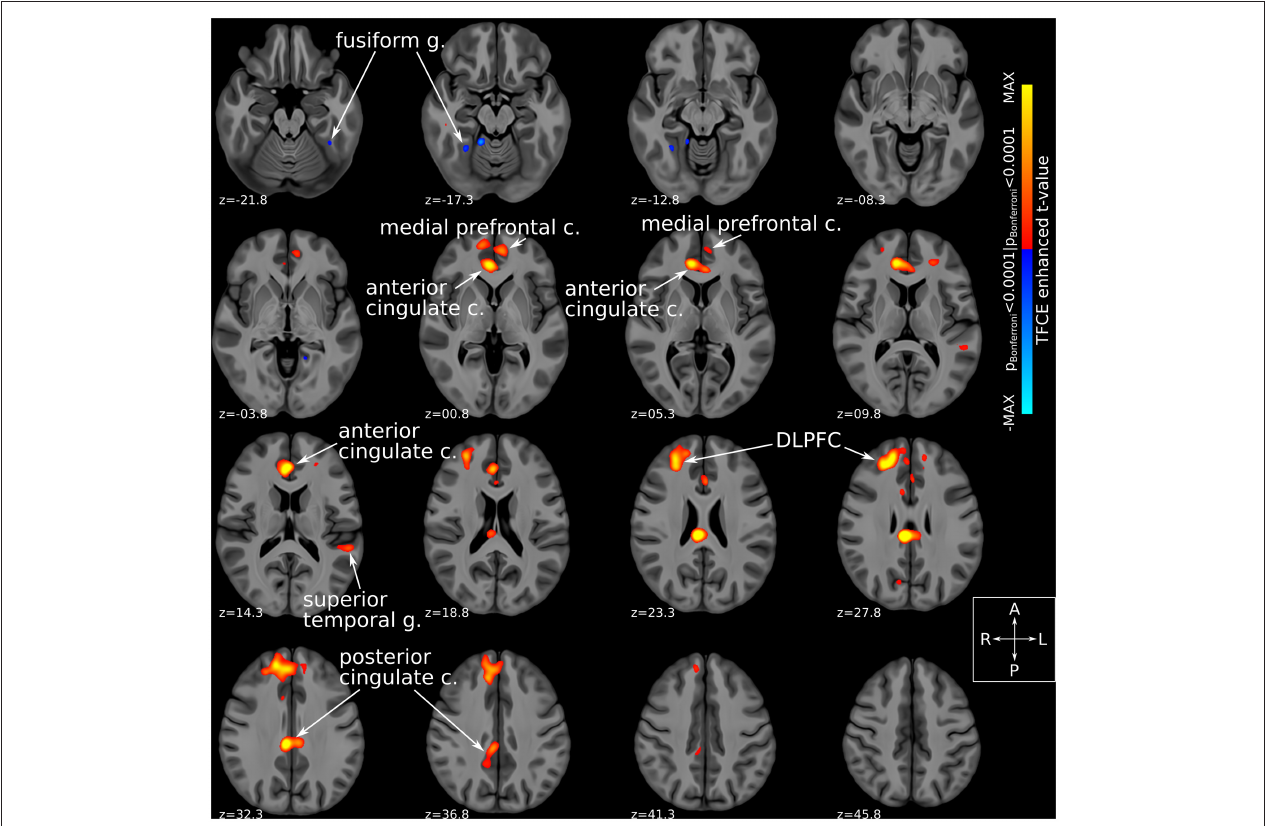
FIGURE 3 | Habenular functional connectivity changes with active SCC-DBS. Change in habenular functional connectivity between DBS-ON and DBS-OFF states. Brain areas that showed a significant change in functional connectivity [TFCE-adjusted p Bonferroni < 0.0001 (52)] between these states are superimposed on axial slices of a high resolution, high contrast brain template (53) in MNI standard space (42). Red/yellow colors denote areas that were more functionally connected with the bilateral habenula in the DBS-ON condition, while blue colors denote areas that showed less habenular connectivity in the DBS-ON state. Many of the areas whose habenular connectivity changed with SCC-DBS are known to be part of the “brain-wide network of depression.” c. , cortex; DBS , deep brain stimulation; DLPFC , dorsolateral prefrontal cortex; g. , gyrus; MNI , Montreal Neurological Institute; SCC , subcallosal cingulate area; TFCE , threshold-free cluster